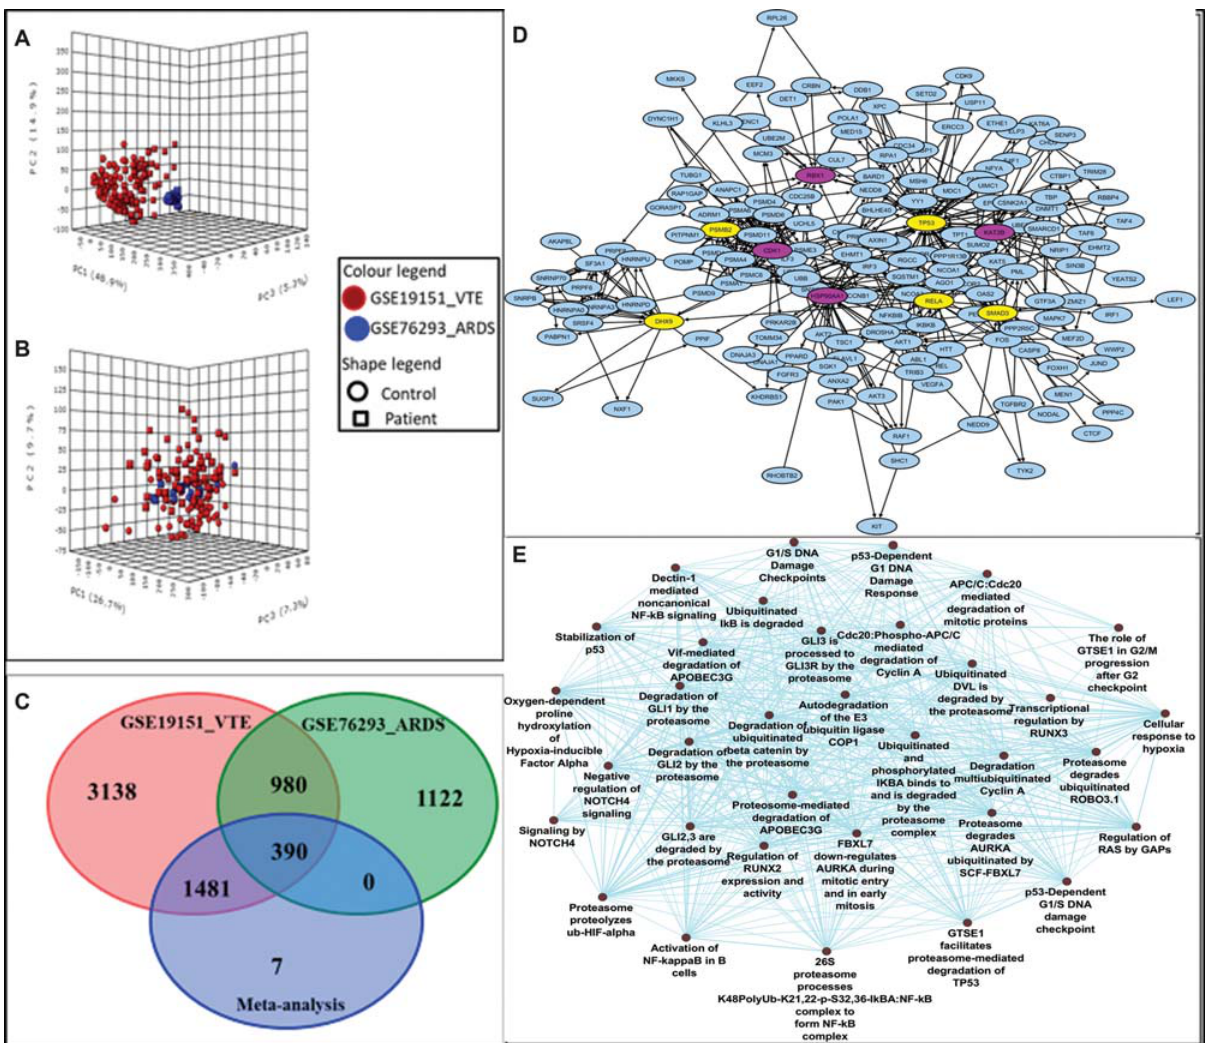
Fig. 2 Result illustrations of comprehensive transcriptomics meta-analysis between acute respiratory distress syndrome (ARDS) and venous thromboembolism (VTE) using integrative meta-analysis of expression data (INMEX) tool ( A ) Plot of principal component analysis (PCA) as validation tool before batch effect removal and ( B ) after batch effect removal (using Combat method). ( C ) The Venn diagram comparing differentially expressed genes (DEGs) sets identi fi ed by the individual studies and by meta-analysis. The results obtained by the meta-analysis (1,878 DEGs) are compared with DEGs identi fi edbyindividualstudyofVTEandARDS.( D )Networkdepictingzero-orderinteractionofthesharedDEGsinbetweenARDSandVTEdatasets.Among the top 20 hub genes, few selected hub genes known to participate in host-viral interaction are shown in purple (overexpressed genes) and yellow (underexpressed gene) colors using Cytoscape. ( E ) Overrepresentation of pathways and gene ontology categories in biological networks identi fi ed from meta-analysis. Network representations of enriched pathway integrating the Kyoto Encyclopedia of Genes and Genomes (KEGG) and Reactome pathways along with Gene ontology for the selected top 20 hub genes using ClueGO Cytoscape plug-in. Hyper-geometric enrichment distribution tests, with an adjusted p -value of (cid:1) 0.05, followed by the Bonferroni adjustment for the terms and term groups were selected based on the highest signi fi